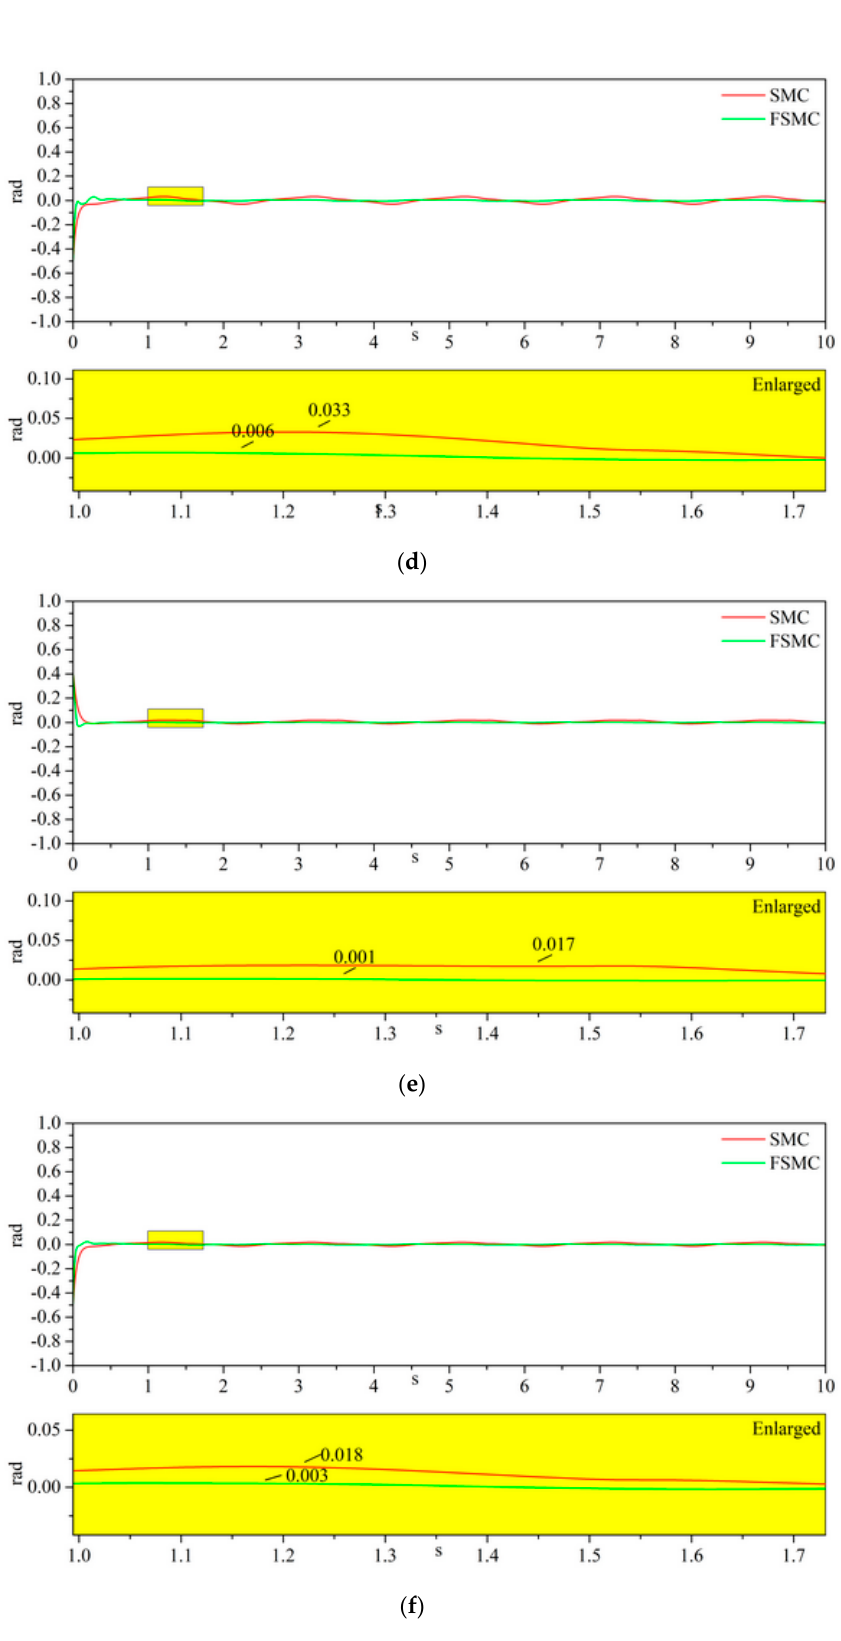
Figure 3. Joint tracking error curves under different CGF. ( a ) Tracking error of joint1 with 60% CGF. ( b ) Tracking error of joint2 with 60% CGF. ( c ) Tracking error of joint1 with 40% CGF. ( d ) Tracking error of joint2 with 40% CGF. ( e ) Tracking error of joint1 with 20% CGF. ( f ) Tracking error of joint2 with 20%